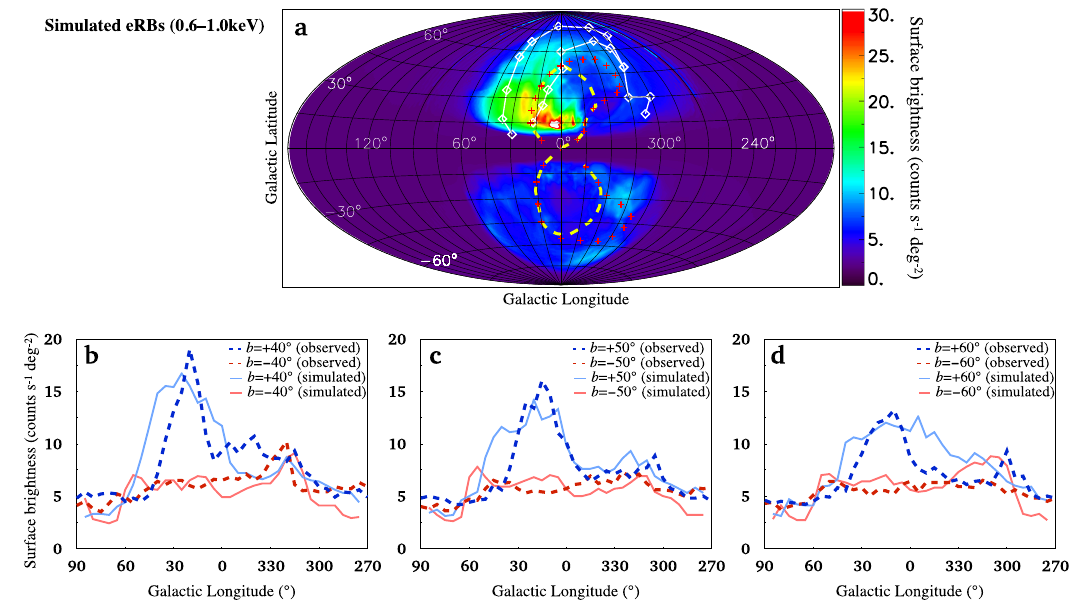
Fig.2|SimulatedeRBs. Panel a showsthesimulatedeRBsfortheCGMwindmodel at t =360+19Myr.Wemaskedtheregionof ∣ Z ∣ <2kpc.EdgesoftheobservedNeRB and FBs are plotted in white line with diamonds (coordinate values are in Supple- mental Note 1) and yellow dashed line 14 , respectively. The red crosses mark the